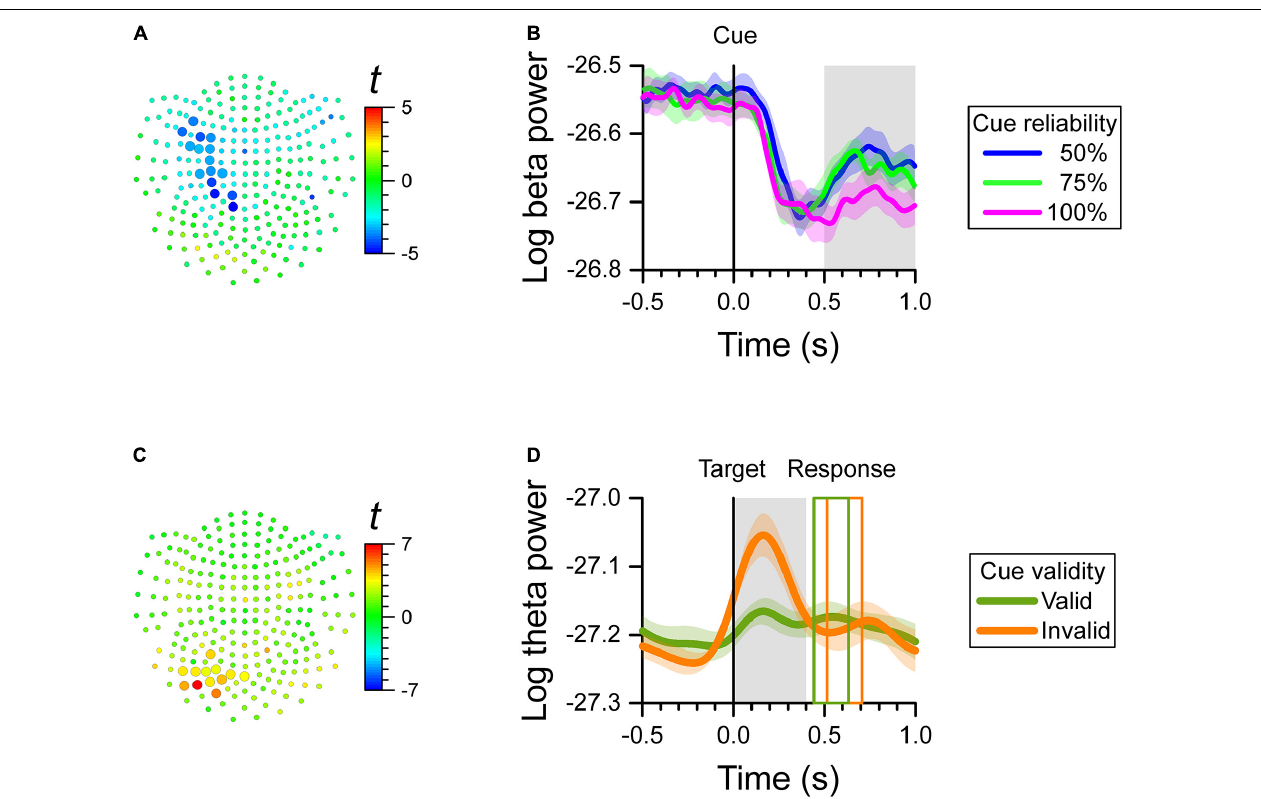
FIGURE 2 | MEG results at the channel level. We found a significant effect of cue reliability on beta power during the late cue period (0.5–1.0 s after cue onset), and a significant cue validity effect on theta power during the reaction time period (0.0–0.4 s after target onset). (A) Map of t -values for the correlation between log-transformed beta power and cue reliability. Channels selected by the cluster-based analysis are plotted as larger symbols. The negative t -values indicate that the greater the cue reliability, the more beta power over left central channels decreased. (B) Cue-aligned time-series of log-transformed beta power of the channels selected in (A) for the 50, 75, and 100% cue reliability conditions. The colored shaded areas indicate the SEM ( N = 12 participants) for within-subject designs. The gray shaded area shows the time-window of interest. (C) Map of t -values for the difference in log-transformed theta power between cue validity conditions. Channels selected by the cluster-based analysis are plotted as larger symbols. The positive t -values indicate that theta power over left posterior channels was greater for the invalid-cue trials than for the valid-cue trials. (D) Target-aligned time-series of log-transformed theta power of the channels selected in (C) for the invalid-cue and valid-cue conditions. The colored shaded areas indicate the SEM ( N = 12 participants) for within-subject designs. The gray shaded area shows the time-window of interest. The colored rectangles show the average onset and offset of the motor response for the valid-cue and invalid-cue